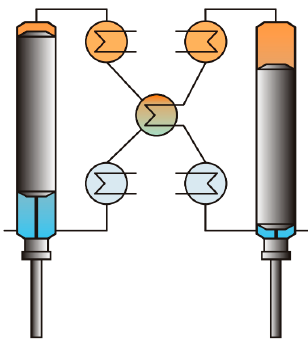
Figure 14. Duplex Bush-type engine, consisting of two individual engines coupled by a common recuperative heat exchanger.